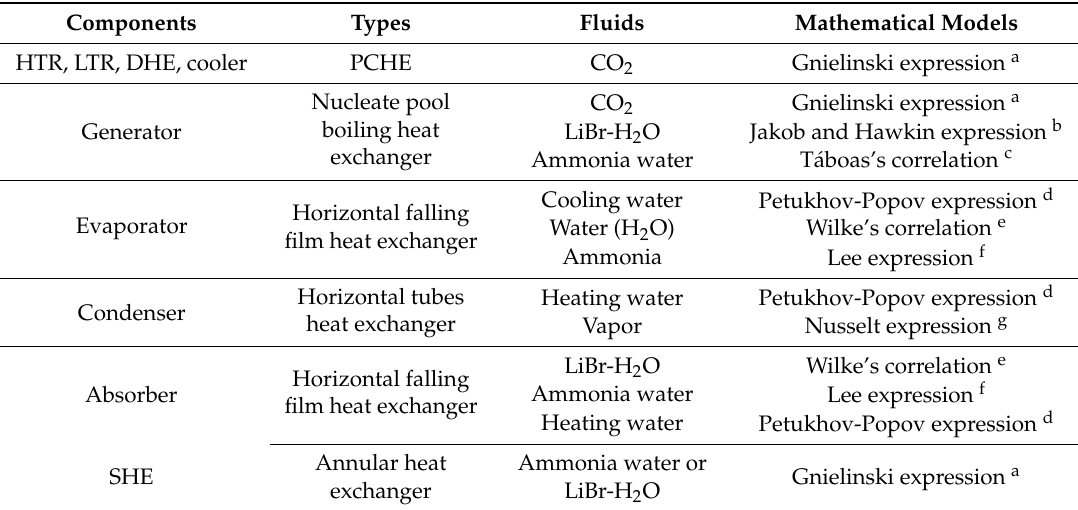
Table 4. Mathematical models for heat